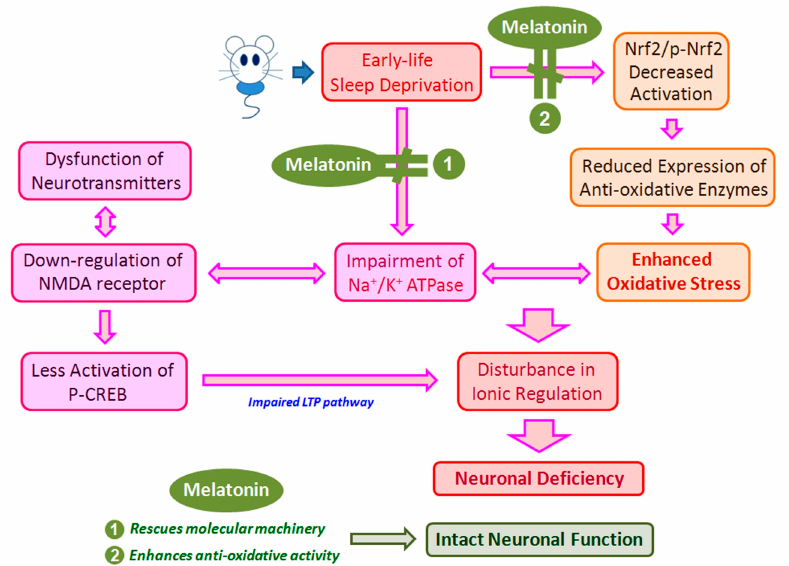
Figure 8. Schematic diagram showed the potential mechanism(s) of early-life sleep deprivation (ESD) on the induction or development of neuronal deficiency. ESD would both impair the Na + /K + ATPase and depress the Nrf2-mediated anti-oxidative enzymes activities that consequently lead to neuronal deficiency through enhanced oxidative stress and cellular bioenergetics disruption. Exogenous application of melatonin could successfully preserve the neuronal function through effectively rescuing the molecular machinery of the neurons and significantly increasing neuronal anti-oxidative